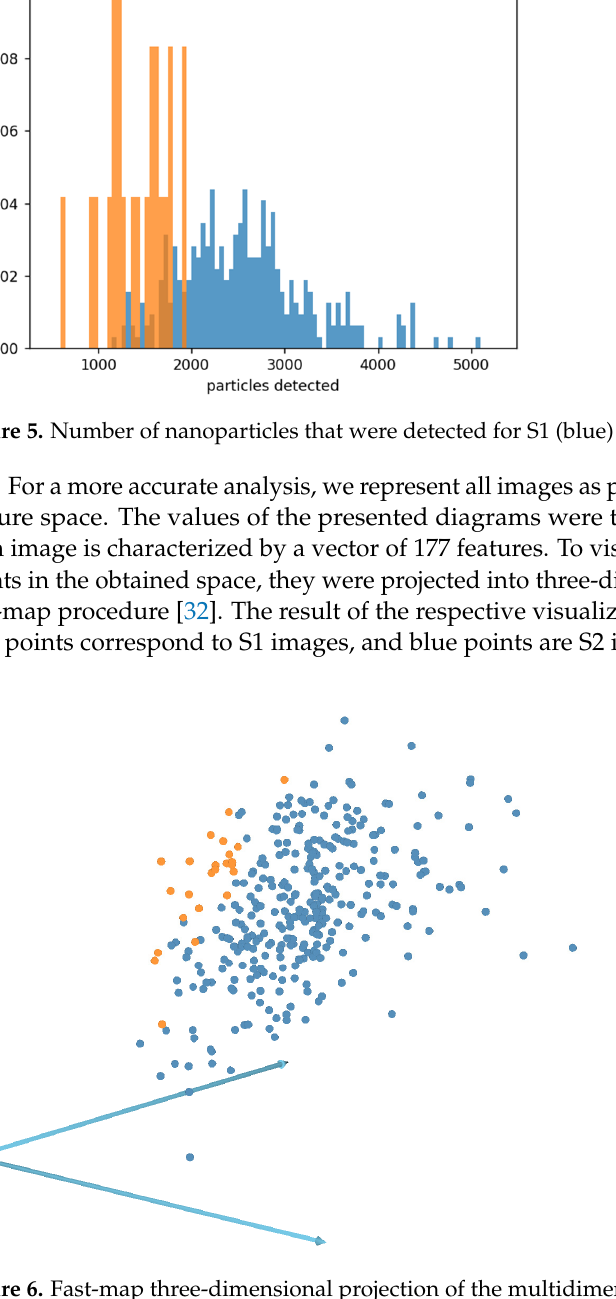
Figure 6. Fast-map three-dimensional projection of the multidimensional feature space. S1 images are drawn in blue, and S2 images are drawn in orange. are drawn in blue, and S2 images are drawn in